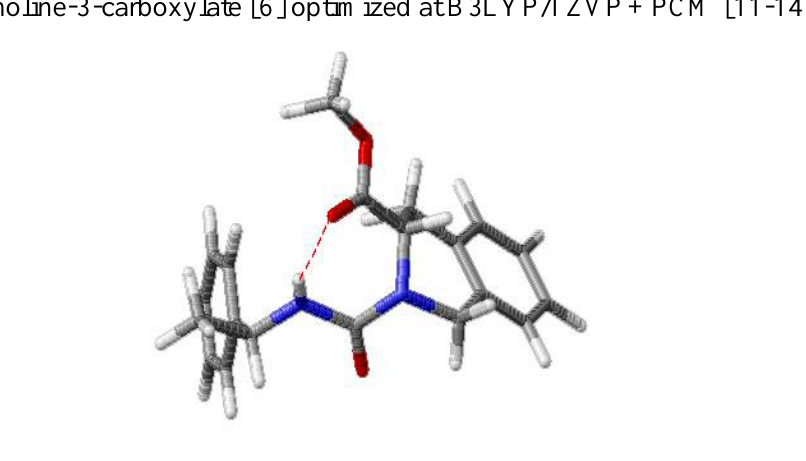
Figure 6. Structure of methyl-(3 S )- N -[(1 S